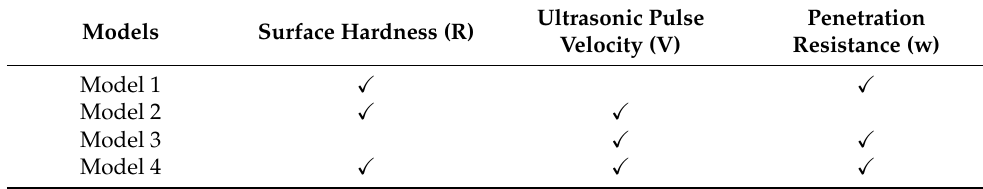
Table 4. Developed models and considered non-destructive test methods.